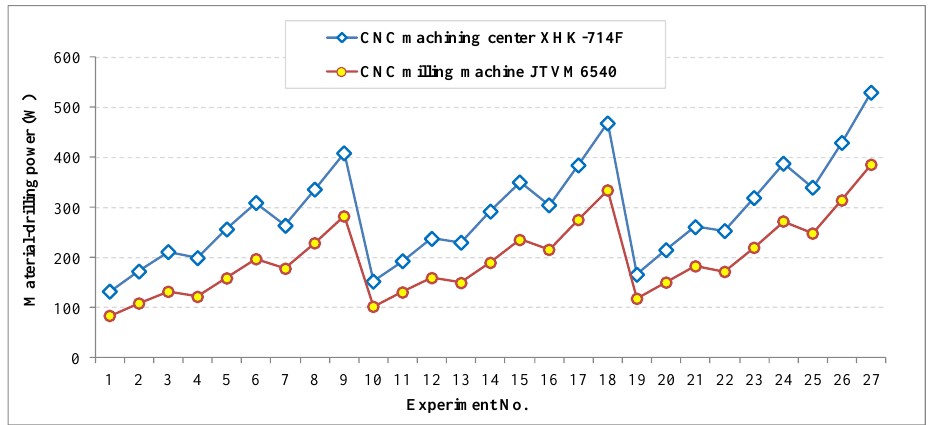
Figure 7. Comparison of the measured material-drilling power for the researched machine tools. Table 2. Measured material-drilling power under different combinations of drilling parameters for